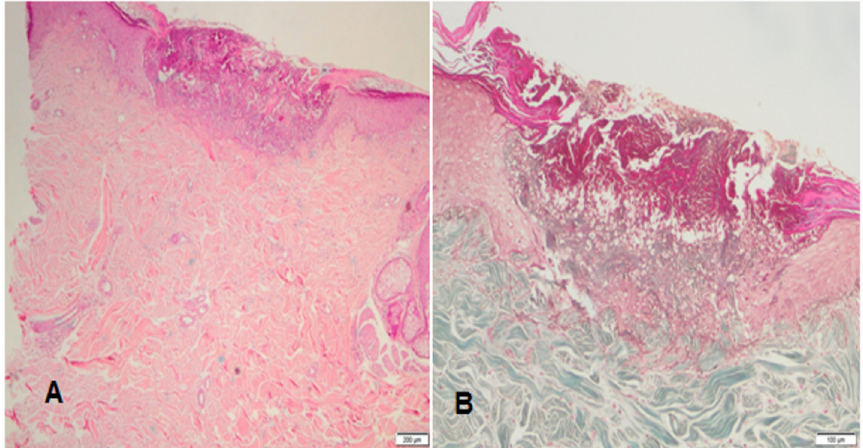
Figure 2: Histopathological features of the reactive perforating collagenosis lesion in our case. A) Cup-shaped depression of the epidermis associated with a keratin plug containing compact ortho- and parakeratosis with granular nuclear debris (H&E). B) Altered collagen fibers in the underlying dermis, with focal extrusion through the epidermis (masson